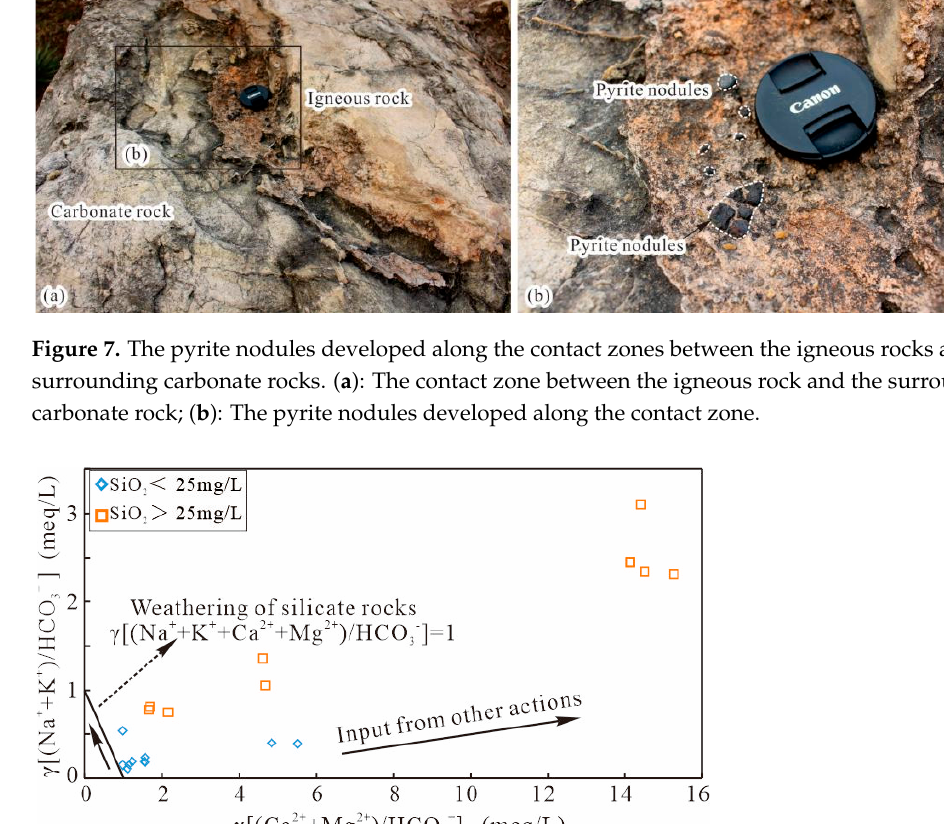
Note: ** indicates a significant precorrelation at 0.01 level, and * indicates a significant correlation at 0.05 level.